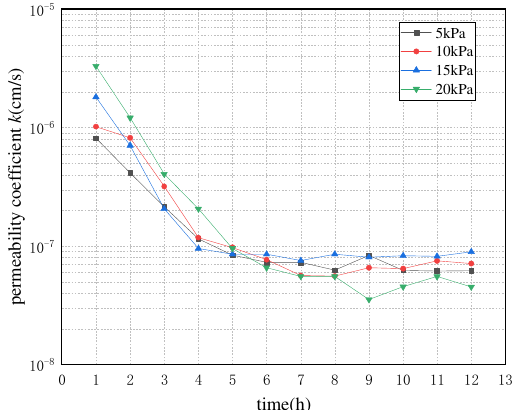
Figure 3. Folding line graph of the variation of permeability coefficient with time for Group C spec- imens under different permeability pressure differences.